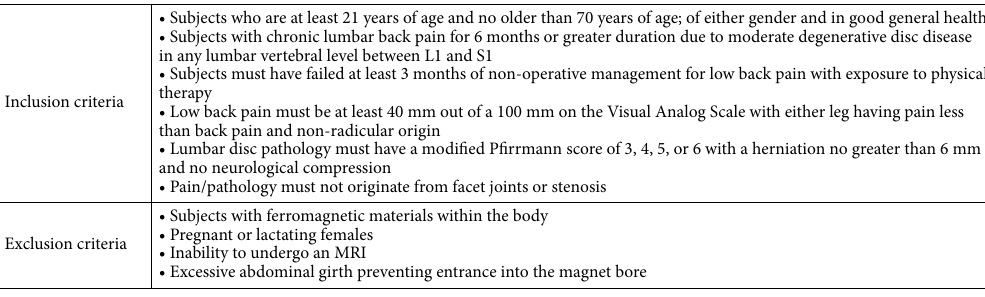
Table 1. Inclusion and exclusion